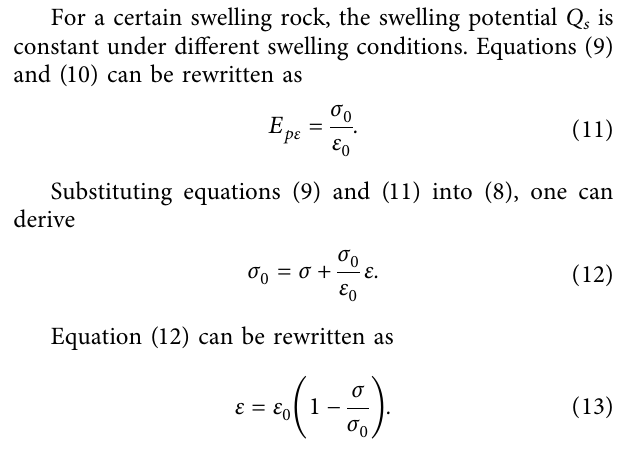
Figure 5: Comparison of measured and calculated swelling stress for gypsum rock. Table 3: Experimental data of Chang et al.